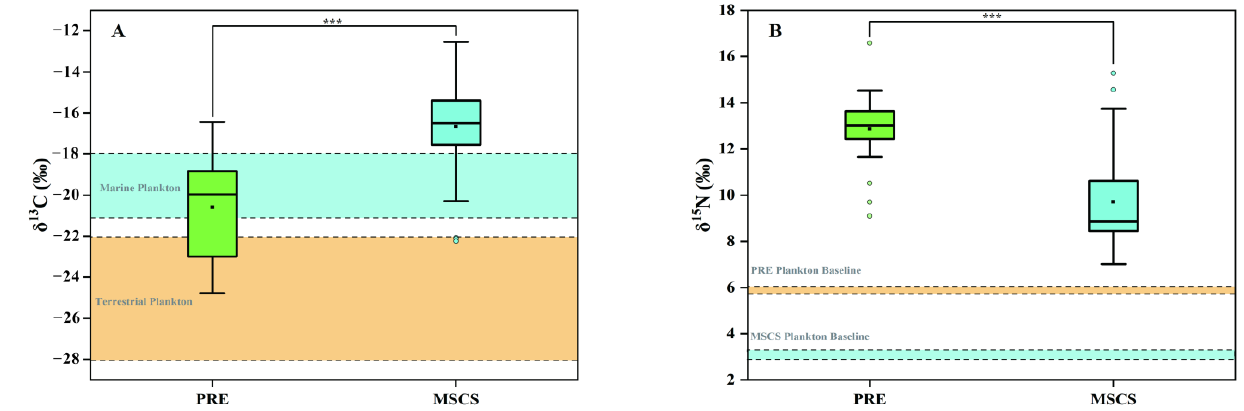
Figure 2. ( A ) Box plot of δ 13 C values in fish collected from the Pearl River Estuarine (PRE) and the middle of the South China Sea (MSCS). The cyan and brown areas represent the range of δ 13 C values in marine plankton and terrestrial plankton reported by previous works [52,53]. ( B ) Box plot of δ 15 N values in fish collected from the PRE and the MSCS. The dashed lines of cyan and brown represent the baseline δ 15 N in phytoplankton collected from the MSCS and the PRE, respectively.*** represents that the data are significantly different between the PRE and the MSCS ( p < 0.001).